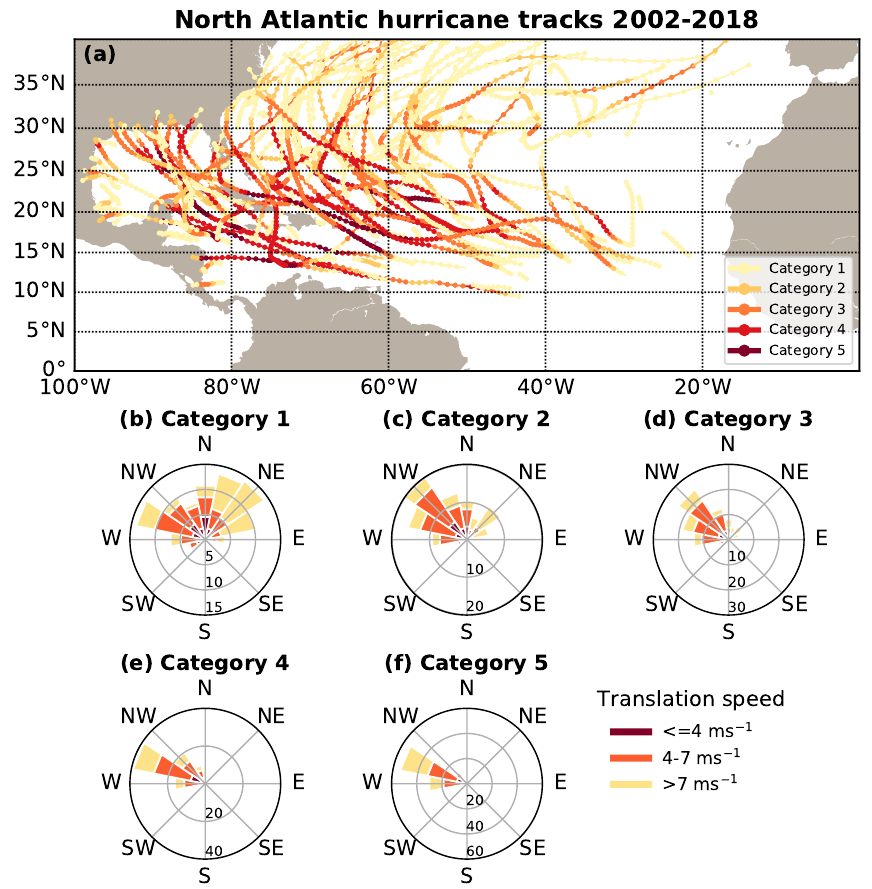
Figure 2. ( a ) Hurricane tracks in the North Atlantic from 2002 to 2018 (both years included). Shading indicates the hurricane category according to the Saffir-Simpson scale (see legend). ( b – f ) Wind-roses for the hurricane categories (1 to 5 respectively) showing the probability distribution (in %) of translation speeds and directions of